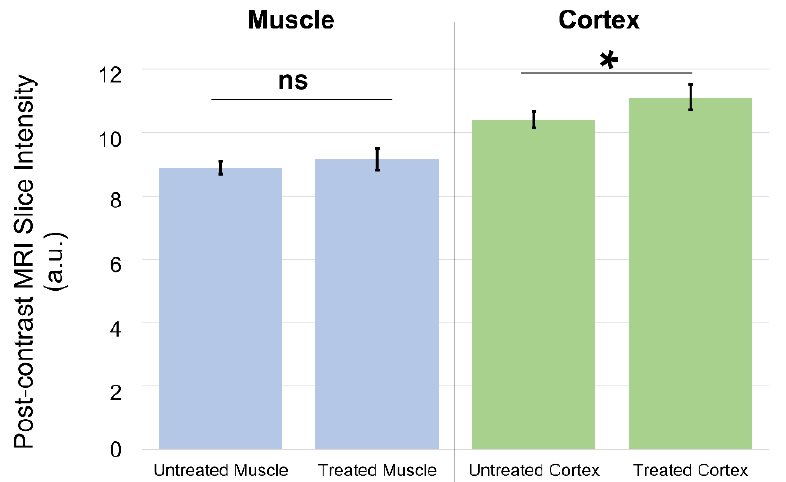
Figure 6. In vivo Gadovist uptake results for muscle and cortex. Comparison of MRI region-of- interest signal in muscle and brain cortex for untreated and treated mice. The muscle shows no statistically significant difference in post-contrast MRI intensity for untreated and treated animals. The cortex shows a statistically significant difference in post-contrast MRI intensity for untreated animals as compared with treated animals. Here, ns indicates results which are not statistically significant, while * indicates statistical significance.